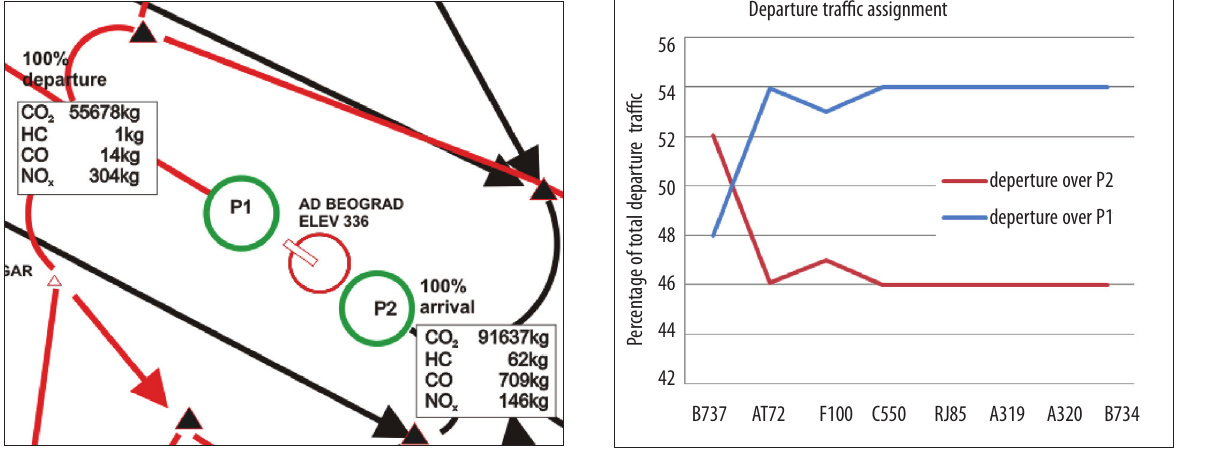
Fig. 11. The proposed scenario 1 of air traffic assignment